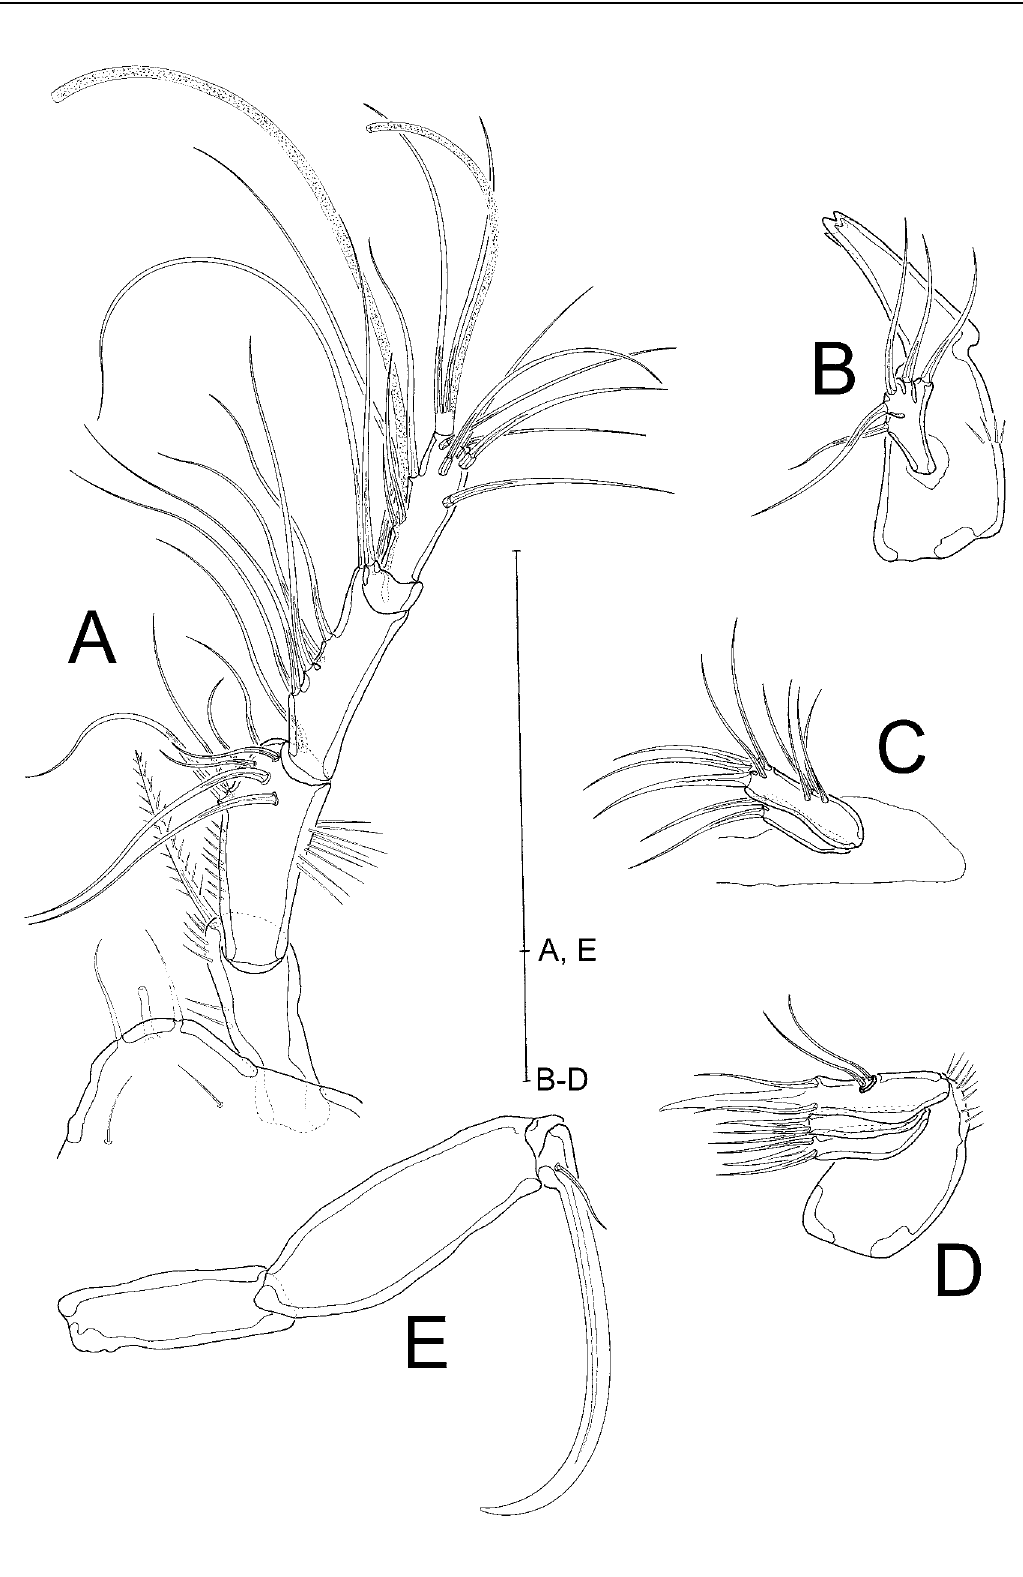
Fig. 17. Laophontodes monsmaris sp. nov. A–B, E . Allotype, ♀ (SMF 37121/1). A . A1 and r. B . Md. C . Holotype, ♂ (SMF 37120/1–2). Mxl coxa and basis. D . Paratype, ♂ (SMF 37121/1). Mx. E . Mxp. Scale bar = 50